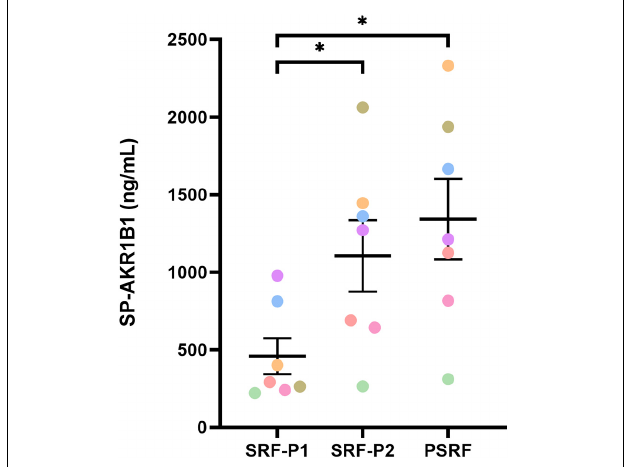
FIGURE 1 | Seminal plasma-AKR1B1 concentration (ng/mL) in the different pig ejaculate fractions: the first 10 mL of the sperm rich fraction (SRF-P1), the rest of the sperm rich fraction (SRF-P2), and post sperm rich fraction (PSRF). Data are represented as mean ± standard error of the mean. Different dot colors represent each individual ( n = 7). Differences between fractions are indicated as * ( P ≤